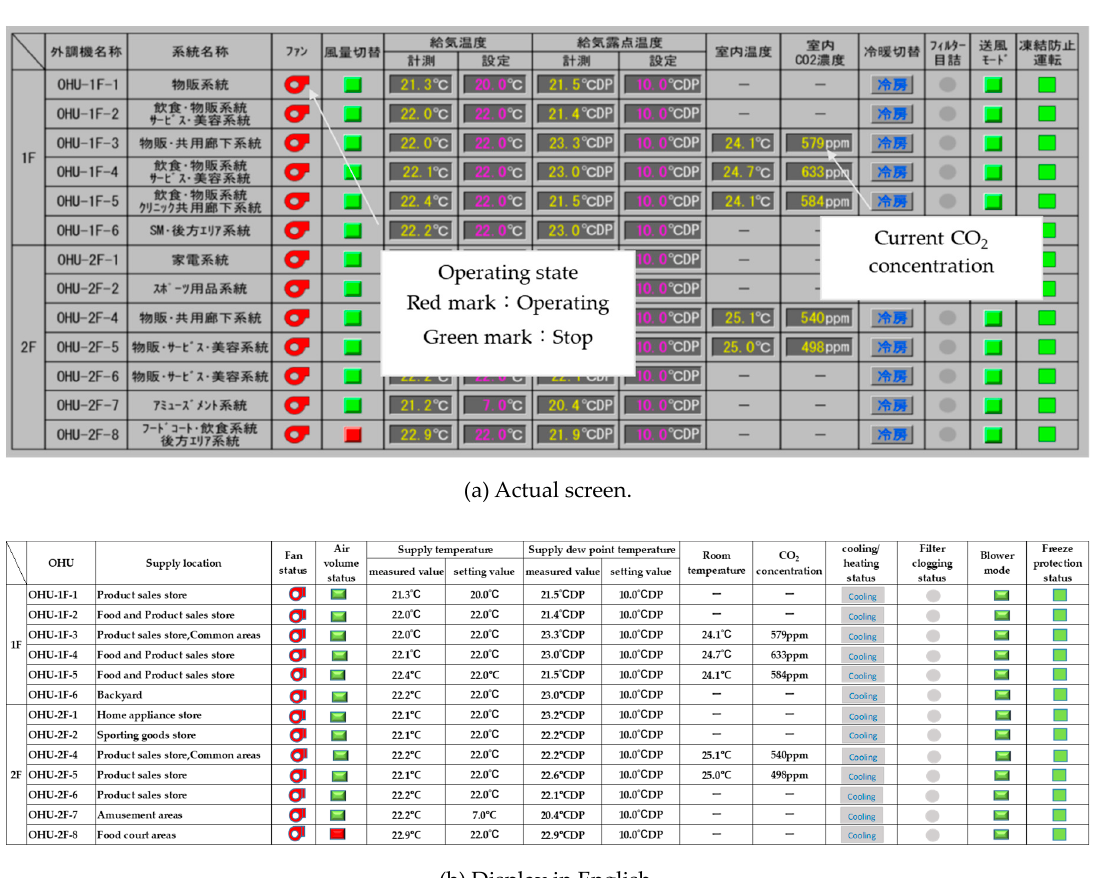
Figure 4. Configuration of heat source system.